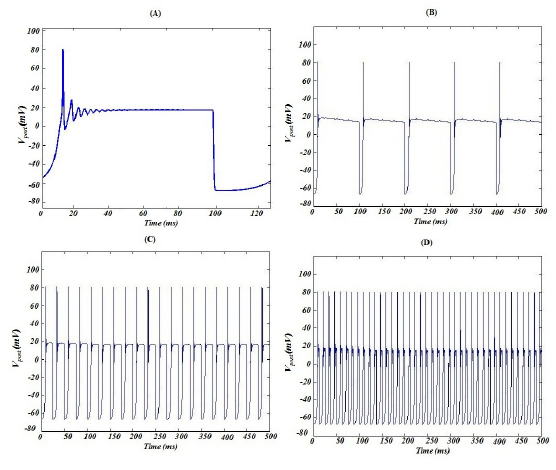
Figure 5. All of the four AMPA , NMDA , GABA A and GABA B channels are active and contributing in rise of postsynaptic potential. Strong excitatory and inhibitory effects are visible. Inhibition is quite strong to develop a sharp hyperpolarization and afterhyperpolarization. Panel (A): An isolated single spike shows the behavior when all four channels are active. Again the experiment is run for three different level of activities, (Panel B:) 10Hz, (Panel C:) 40Hz and (Panel D:)